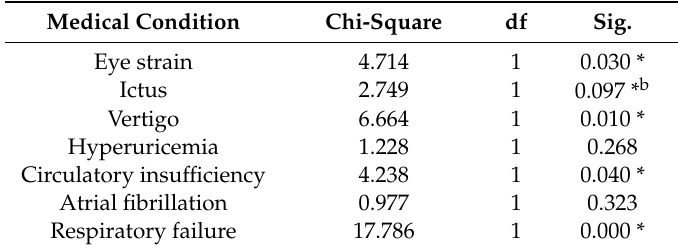
Table 4. Chi-square data and significance values for eye strain, stroke, vertigo, hyperuricemia, circulatory failure, atrial fibrillation, and respiratory